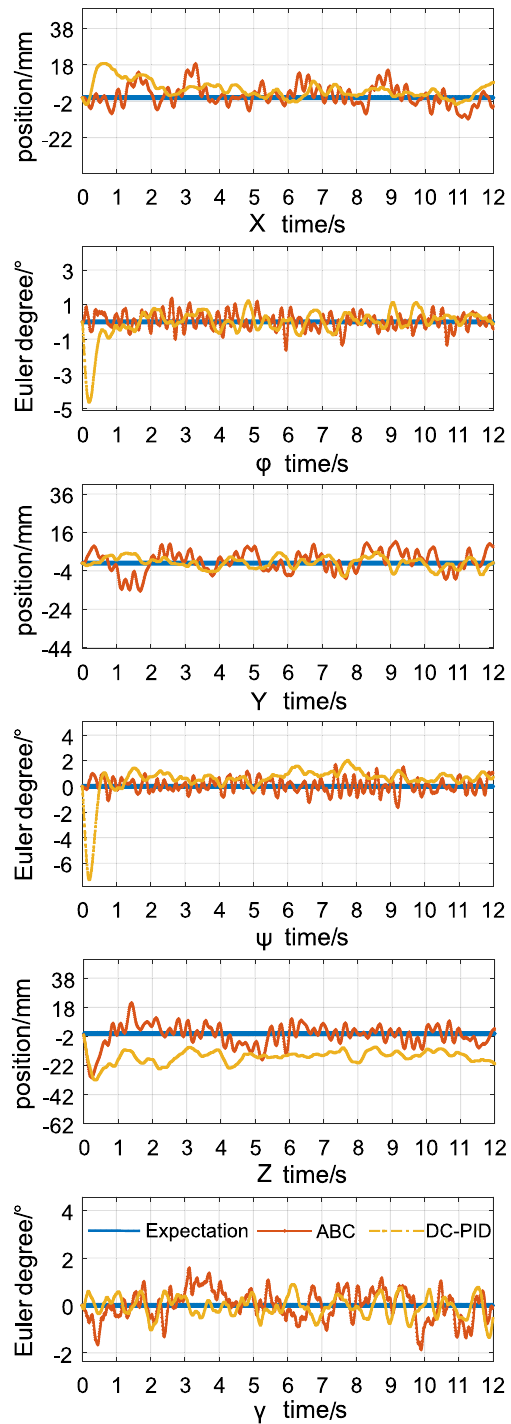
Figure 6. Errors in positions and attitudes for task